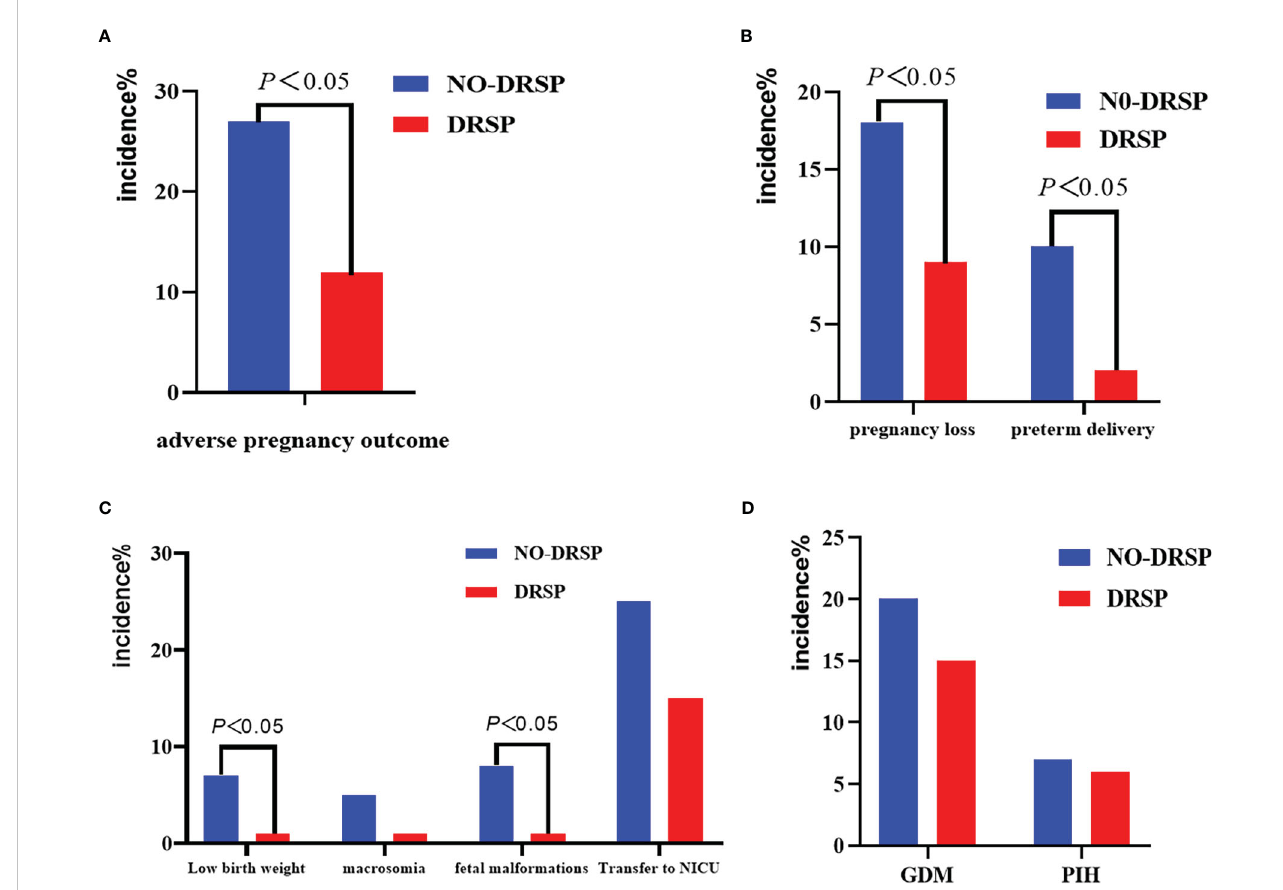
FIGURE 2 Primary and secondary outcomes in patients with polycystic ovary syndrome (PCOS).